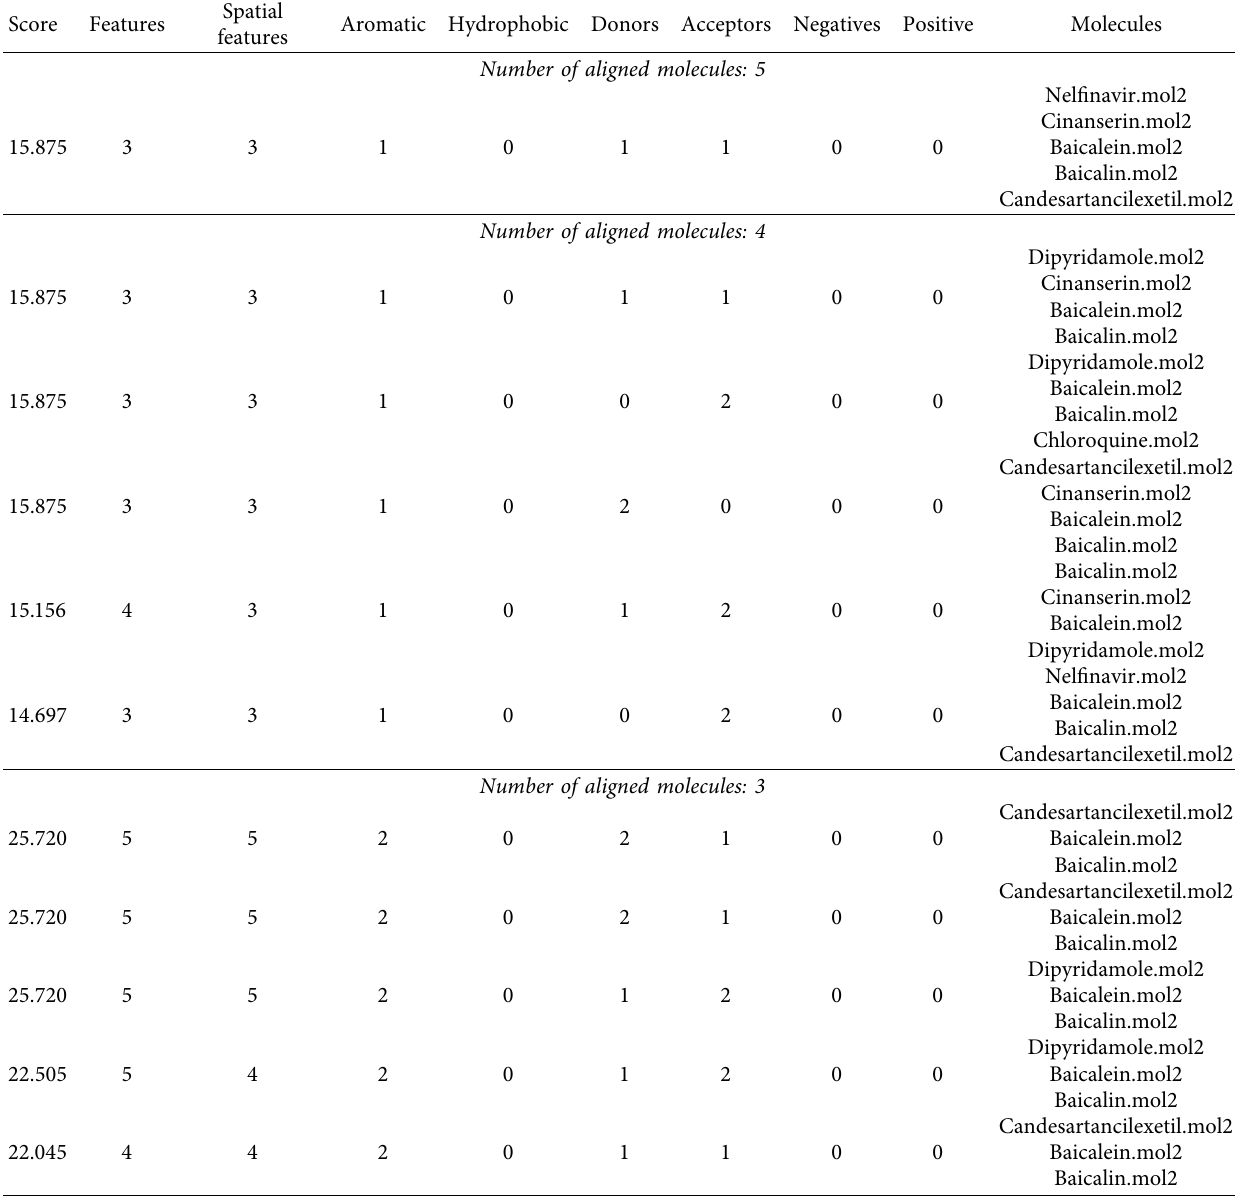
Table 3: Aligned molecules with their common pharmacophore features sorted by score. *e best pharmacophore model is based on the highest number of aligned molecules: 5 with a score of